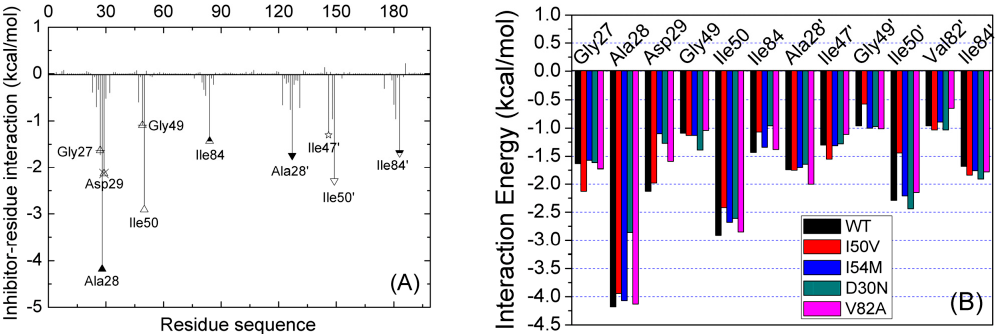
Figure 4. ( A ) Decomposition of Δ G inhibitor-residue on a per-residue basis for the WT; ( B ) comparison of the binding free energy of the key residues for five complexes.